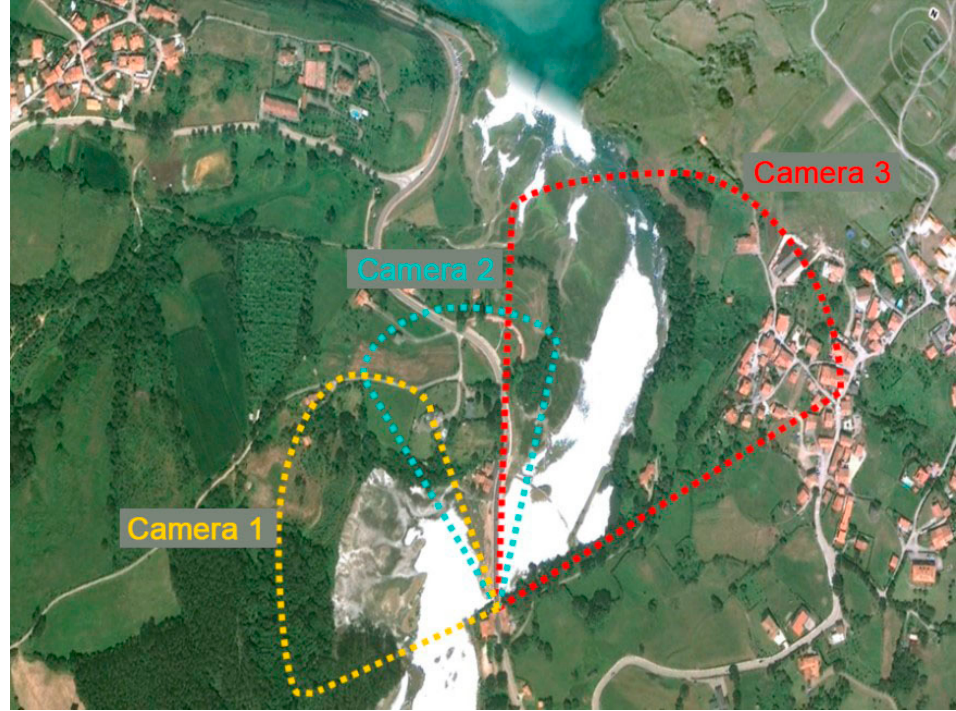
Figure 4. Orientation and area of coverage the cameras in the La Rabia estuary.